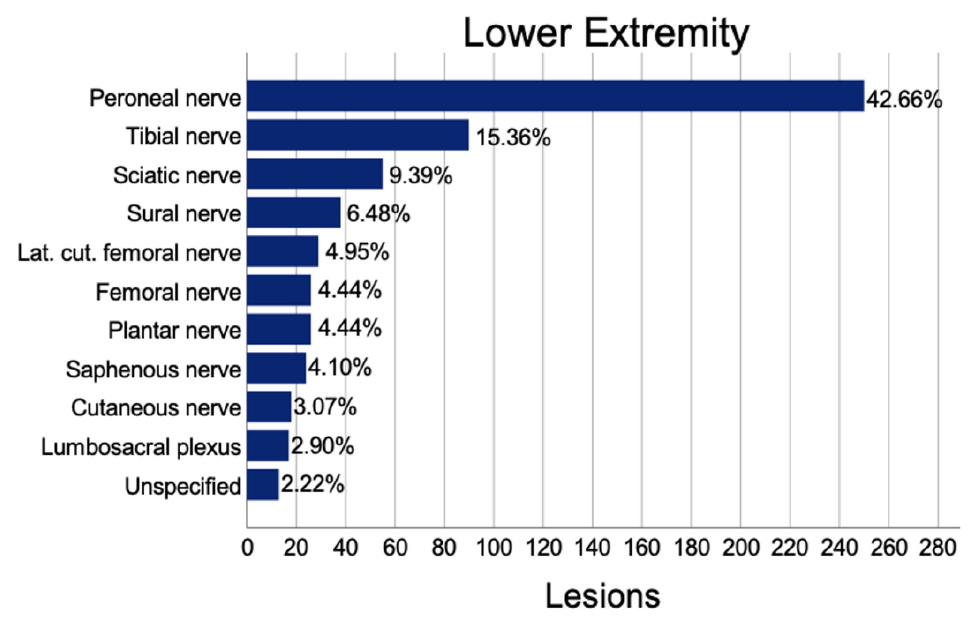
Figure 4. Prevalence of lesions to the lower extremity.